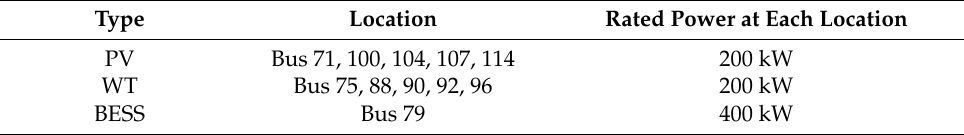
Table 1. Locations and rated power of PVs, WTs, and